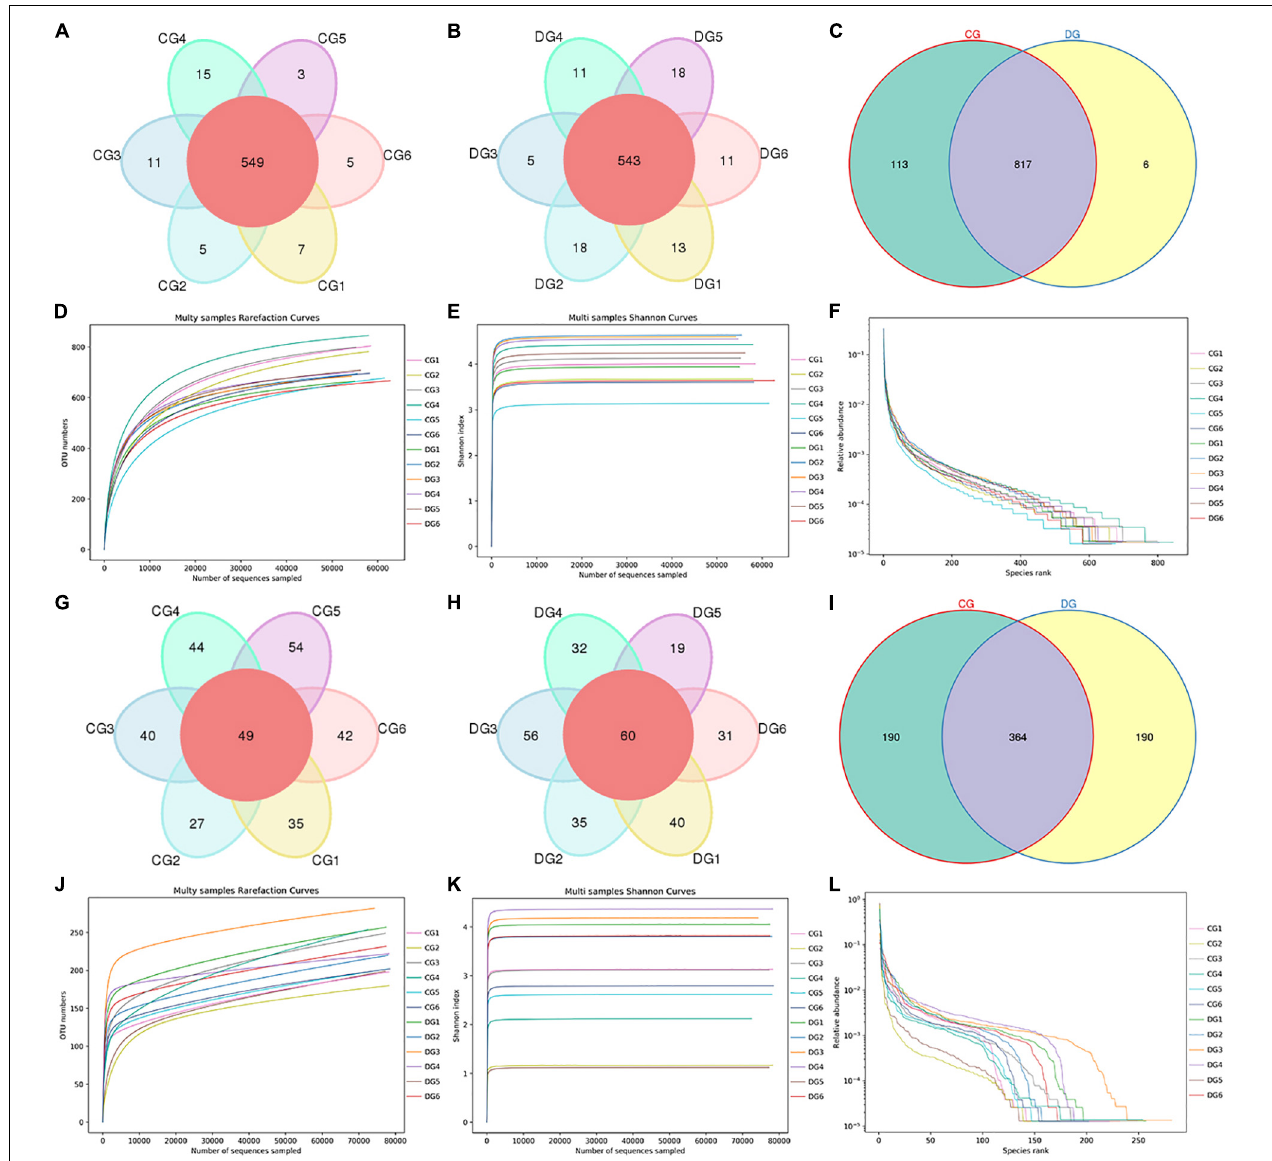
FIGURE 1 | Gut bacterial and fungal OTU distribution and feasibility analysis. (A–C) Venn diagrams for gut bacterial OTU distribution. (D–F) Bacterial rarefaction and rank abundance curves were used for assessing the quality of sequencing including depth, abundance, and evenness. (G–I) Venn diagrams for gut fungal OTU distribution. (J–L) Fungal rarefaction and rank abundance curves were used to evaluate the quality of sequencing including depth, abundance, and evenness. Each colored curve displayed in the figures represents a